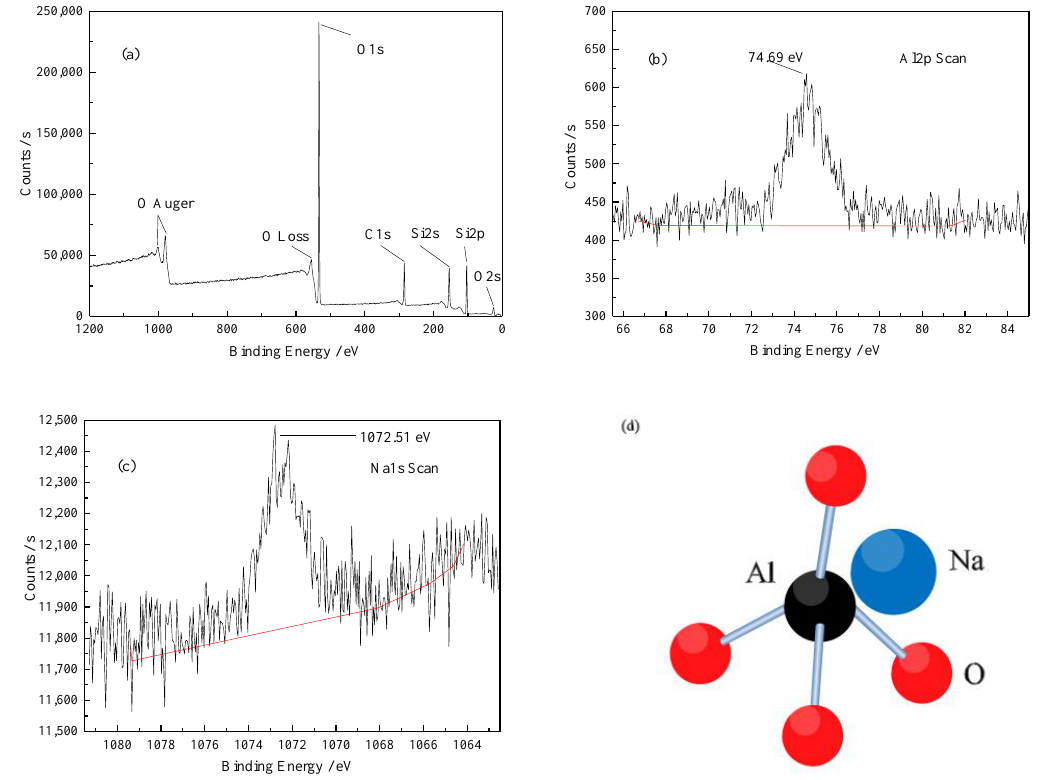
Figure 9. X-ray photoelectric spectroscopy and structure simulation of quartz concentrate: ( a ) broad spectrum of quartz concentrate; ( b ) narrow spectrum of Al; ( c ) narrow spectrum of Na; and ( d ) structural simulation of lattice substitution.